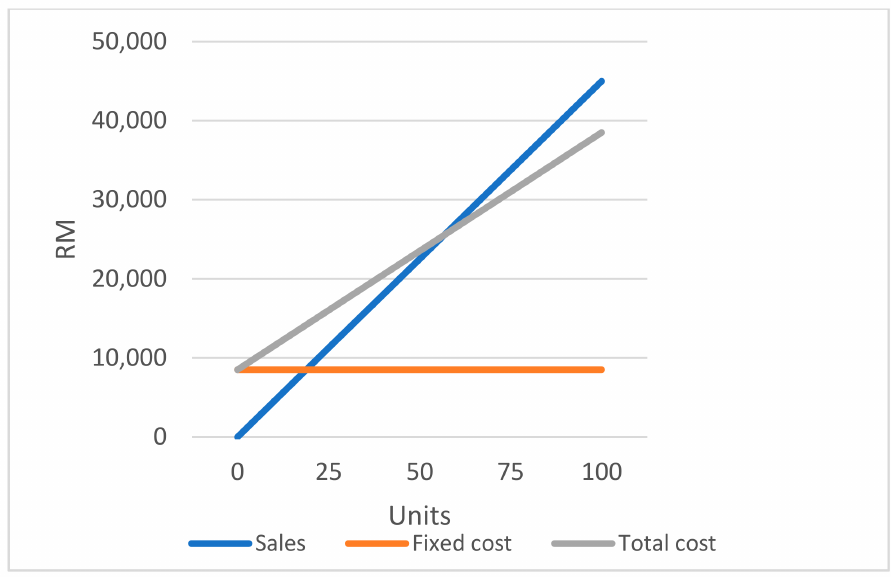
Figure 10. Break-even analysis graph for case